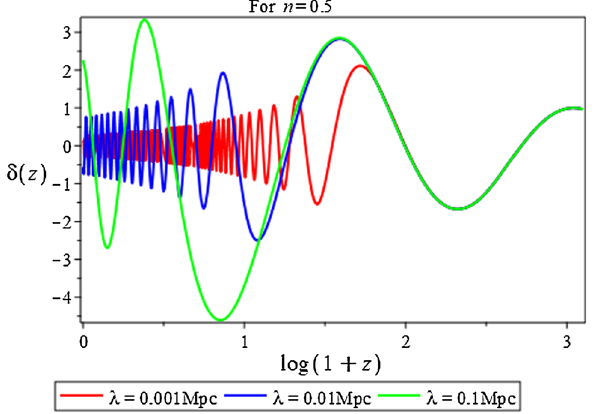
Fig. 8 δ( z ) versus z for Eq. (112) for short-wavelength mode different λ at n = 0 . 5